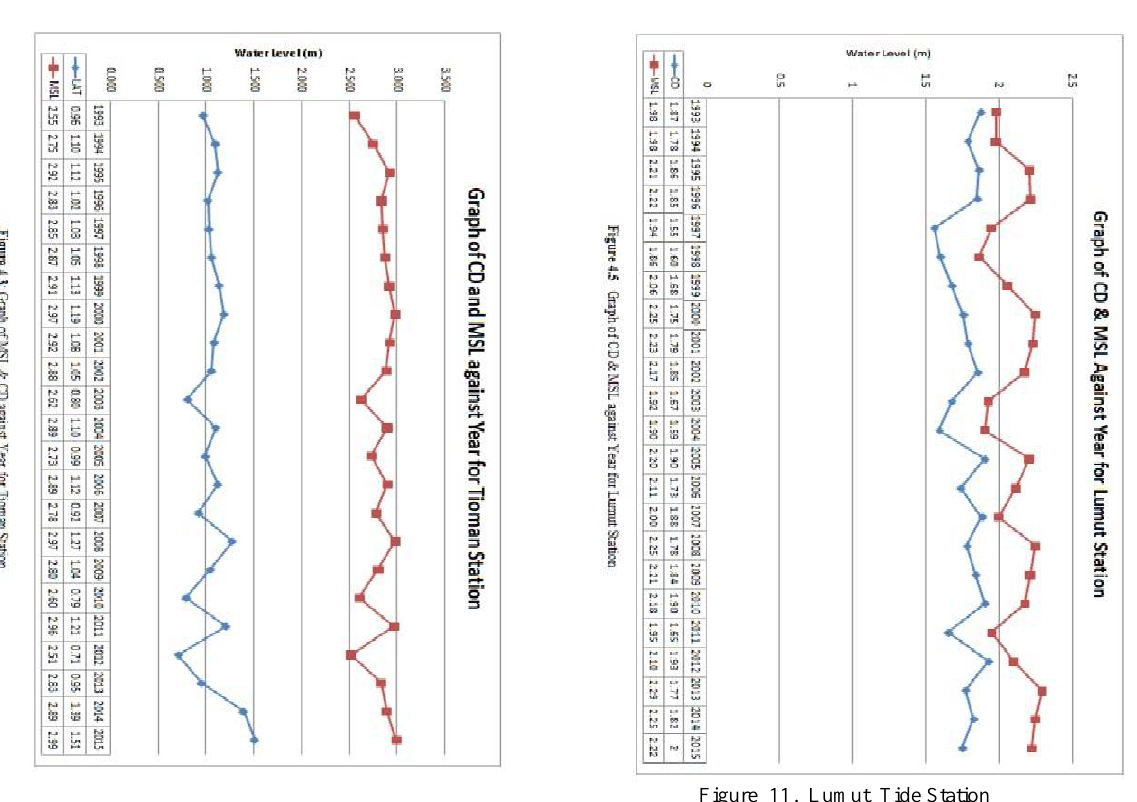
Figure 9. Tioman Tide Station